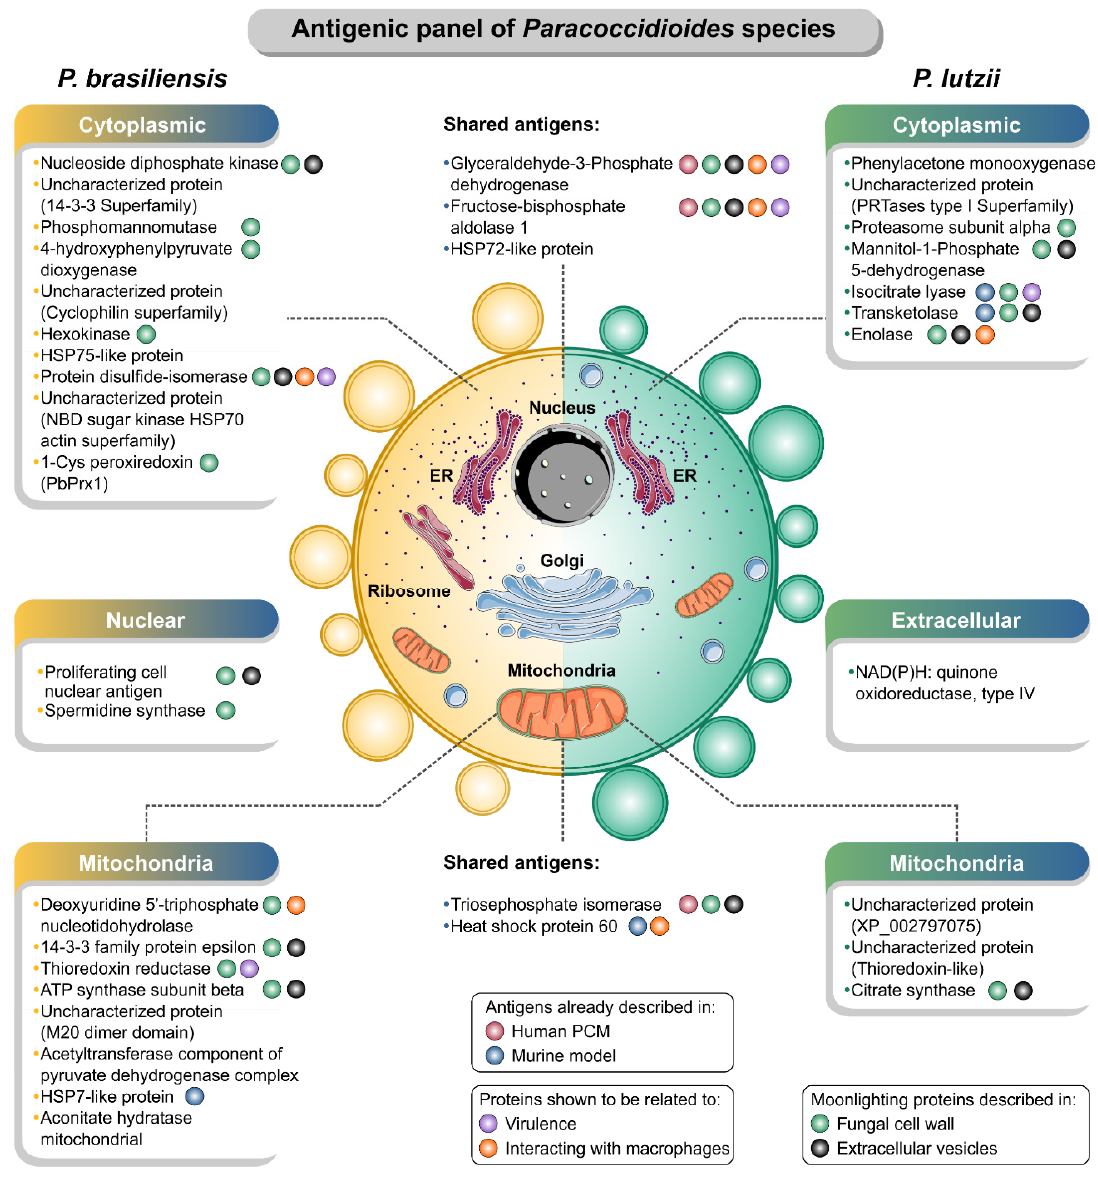
Figure 9. A panel of immunogenic proteins in paracoccidioidomycosis caused by P. brasiliensis sensu stricto (left) and P. lutzii (right). The immunogenic proteins were grouped according to the subcellular localization predicted by the WoLF PSORT [69]. Pieces of information about the report of these proteins as antigens in human [70] or murine PCM [71], the presence in the cell wall [95,116,126] and extracellular vesicles [90], during interaction with macrophages [122] or associated with virulence processes in Paracoccidioides [54,57,106] were noted. The illustration was partially based on